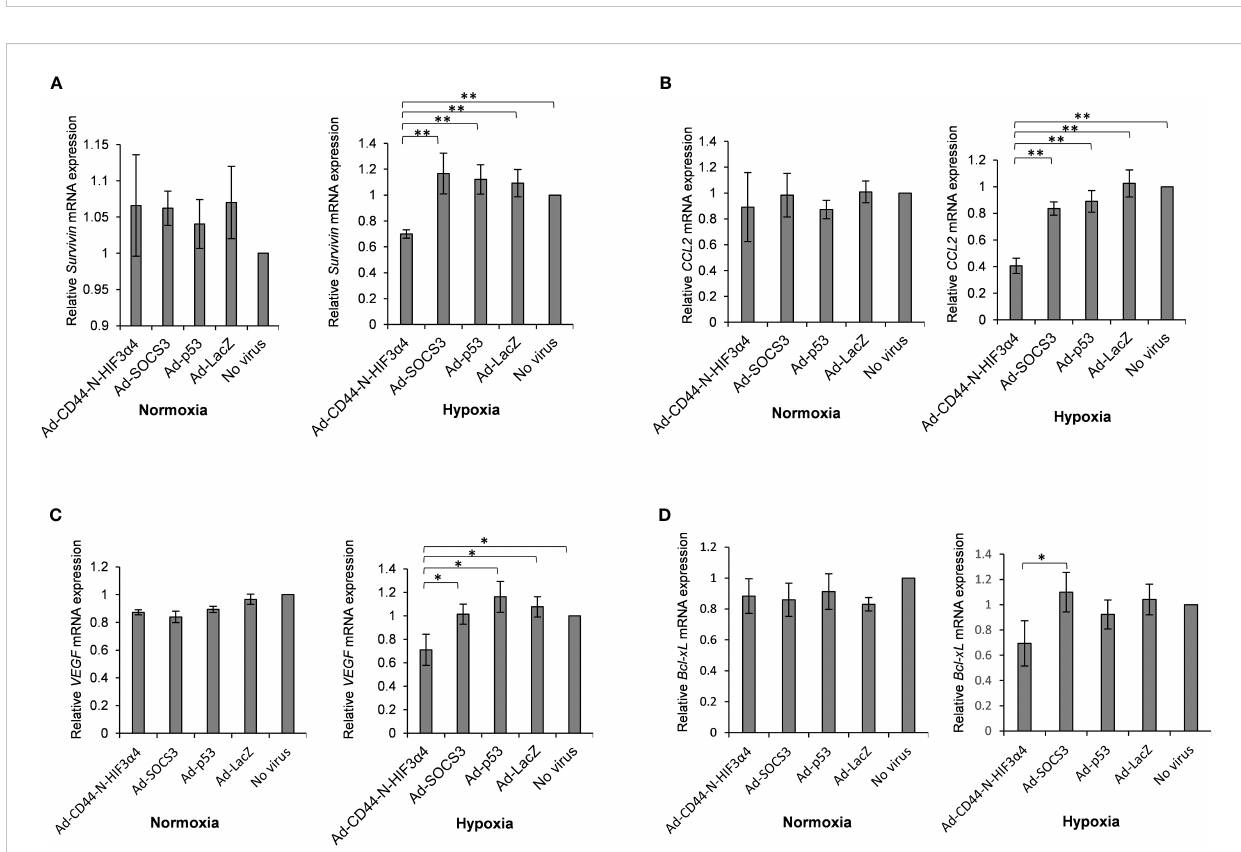
FIGURE 7 Gene expression of survivin , CCL2 , VEGF and Bcl-xL in MDA-MB-231 cells infected with adenovirus vectors were measured by real-time RT-PCR. Cells were cultured under hypoxic conditions or under normoxic conditions. The signi fi cantly decreased mRNA expressions of (A) survivin and (B) CCL2 were observed in cells infected with Ad-CD44-N-HIF3 a 4 compared to cells infected with the other adenovirus vectors and no virus only in the culture conditions under hypoxic. The signi fi cantly decreased mRNA expressions of (C) VEGF and (D) Bcl-xL were observed in cells infected with Ad-CD44-N-HIF3 a 4 compared to cells infected with the other adenovirus vectors and no virus only in the culture conditions under hypoxic. mRNA levels were standardized by the expression levels of control gene TBP . (n=3, average ± SE bars, *p< 0.05,**p<